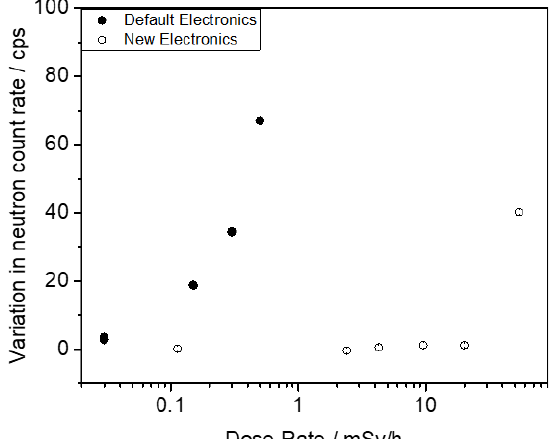
Fig. 4. Change in the total neutron count rate without 252 Cf source as a function of the dose for the system with the default and new electronics.